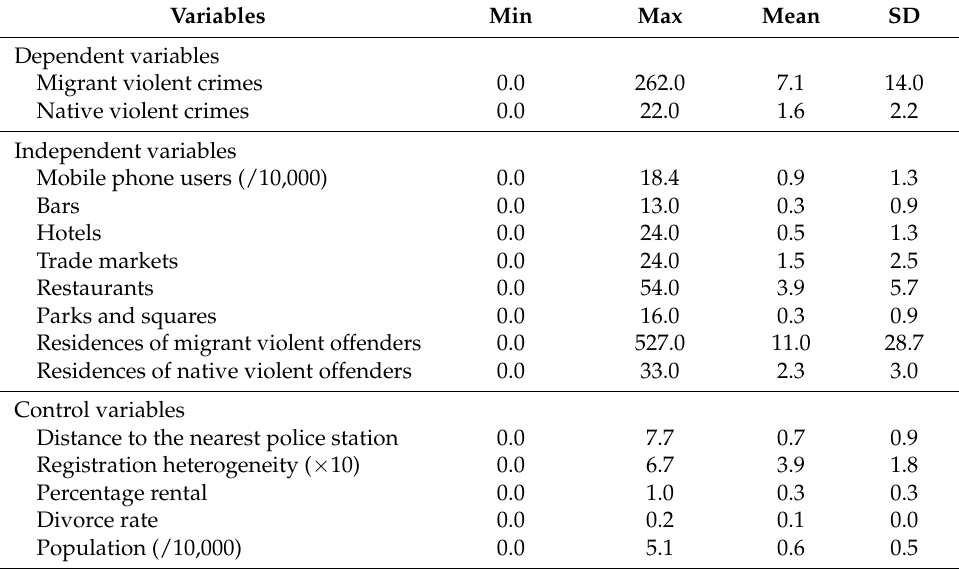
Table 3. Descriptive statistics of dependent variables and independent